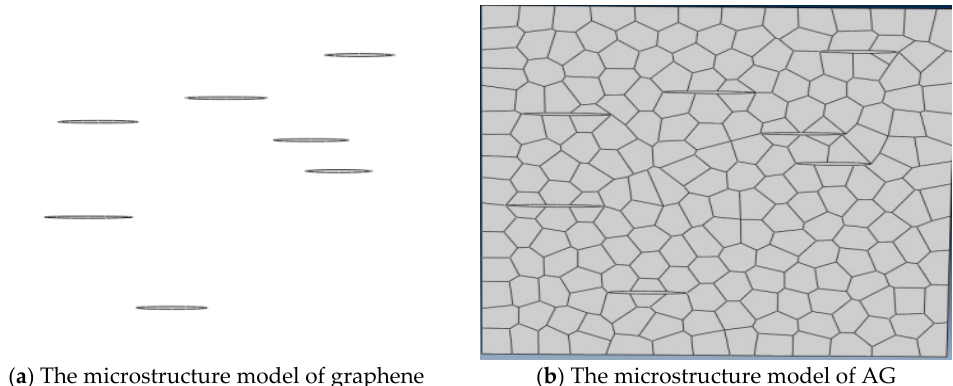
Figure 1. Microstructure model of composite ceramic tool material [32]. AG, alumina/graphene composite